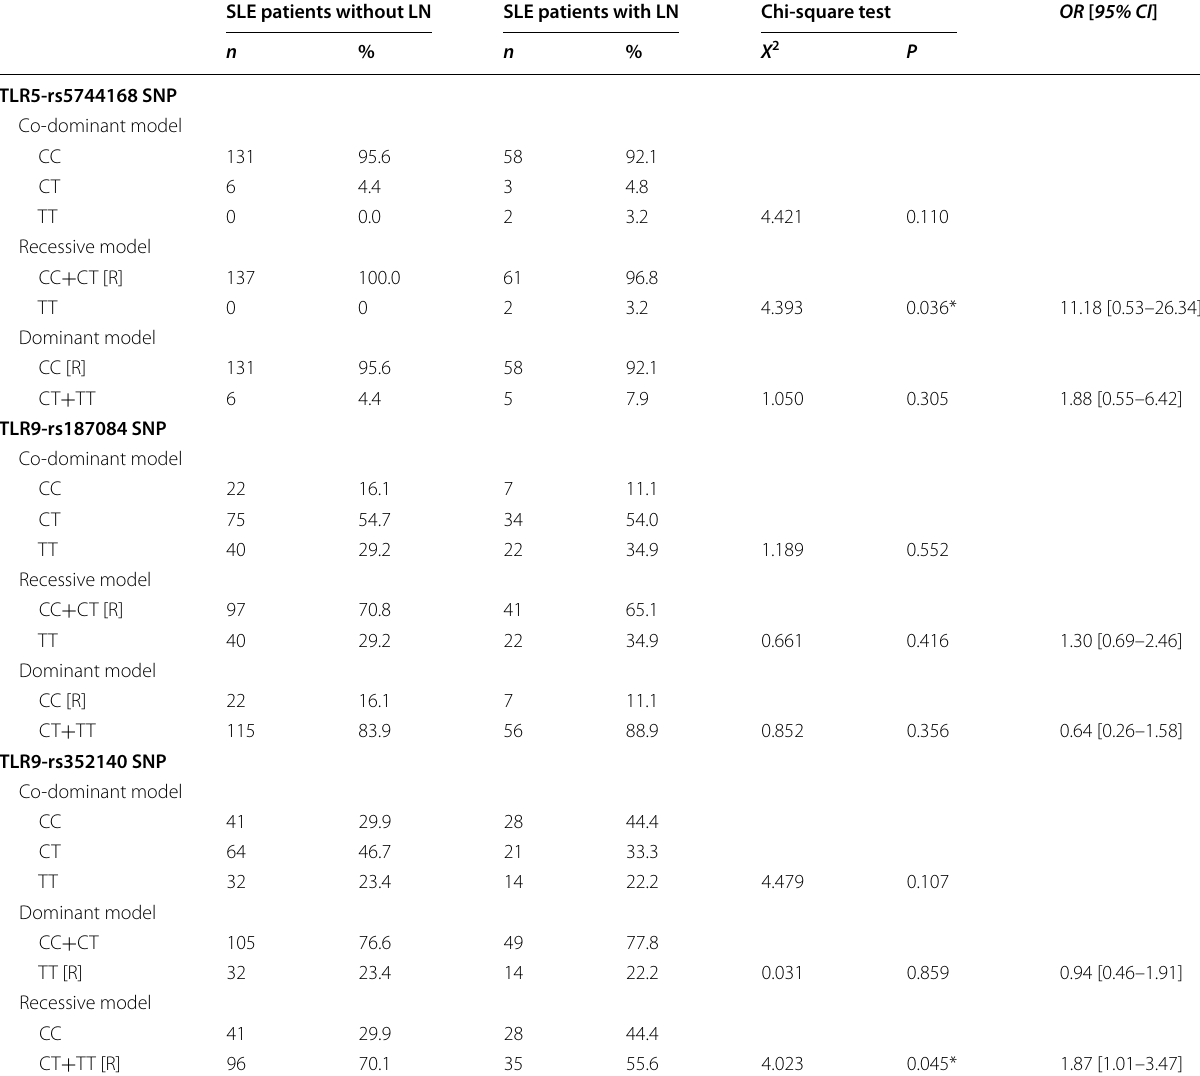
Table 6 Comparison of genotyping distribution of TLR9 gene SNP rs187084 and TLR5 gene SNP rs5744168 between SLE patients with and without